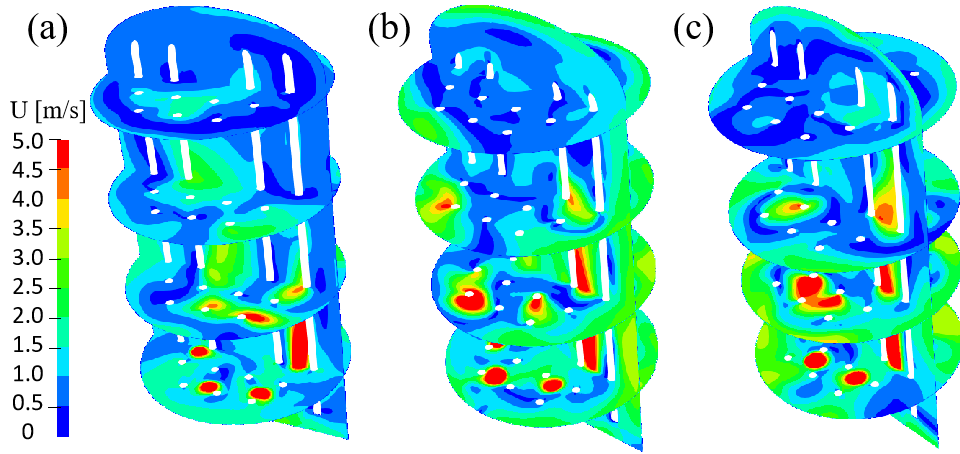
Figure 6. Flow field distribution. ( a ) Design A; ( b ) design B; ( c ) design C (height of horizontal sections is the same as in Figure 4).